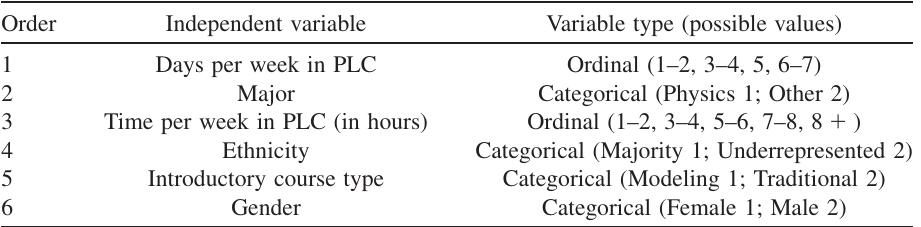
TABLE I. Independent variables used in hierarchical multiple regression, variable type, and order of entry into regression model.